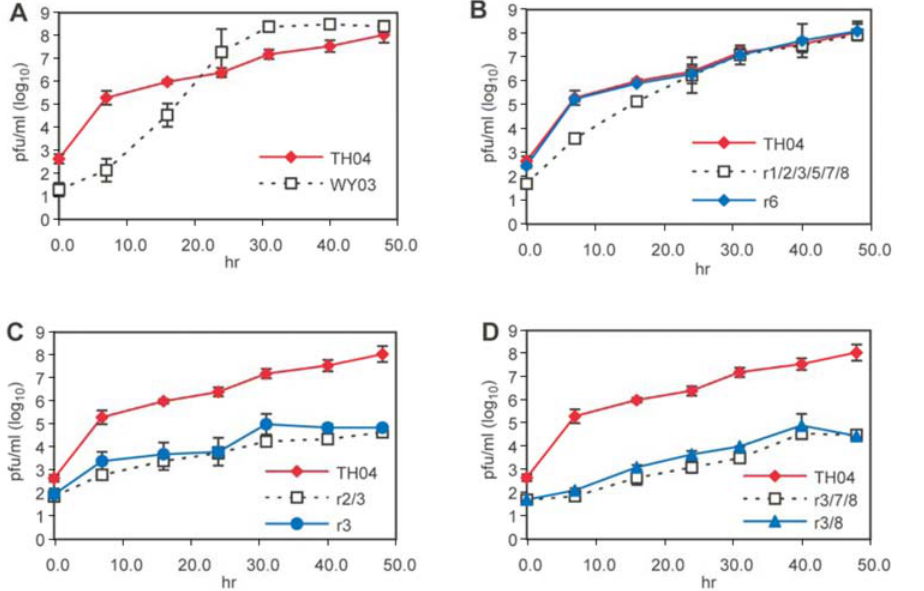
Figure 4. Replication kinetics of avian-human reassortant viruses in differentiated human tracheobronchial epithelial (HTBE) cells. HTBE cells were infected in duplicate with parental TH04 and WY03 (A) or rH5N1 viruses (B, C, D) at an moi of 0.02; progeny viruses were collected and titrated on MDCK cells.